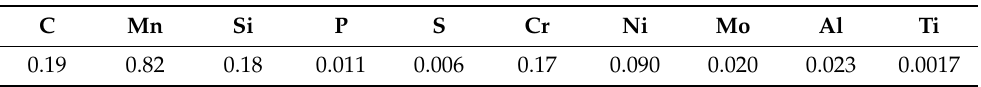
Table 1. Contents of alloying elements (wt%) in P250GH steel investigated in the present work, as-stated by inspection